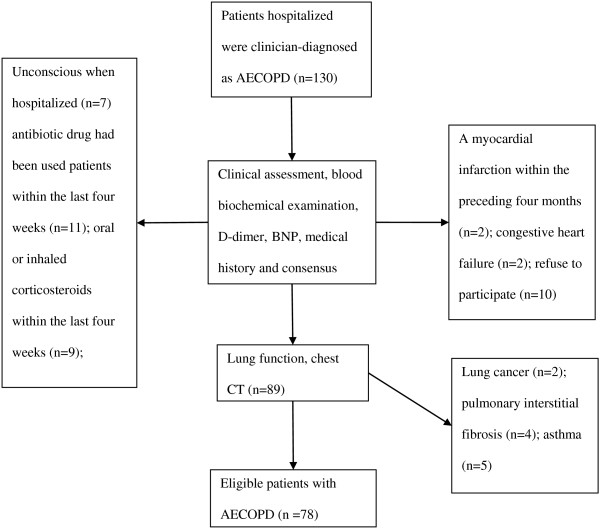
Strategies for screening patients with AECOPD.